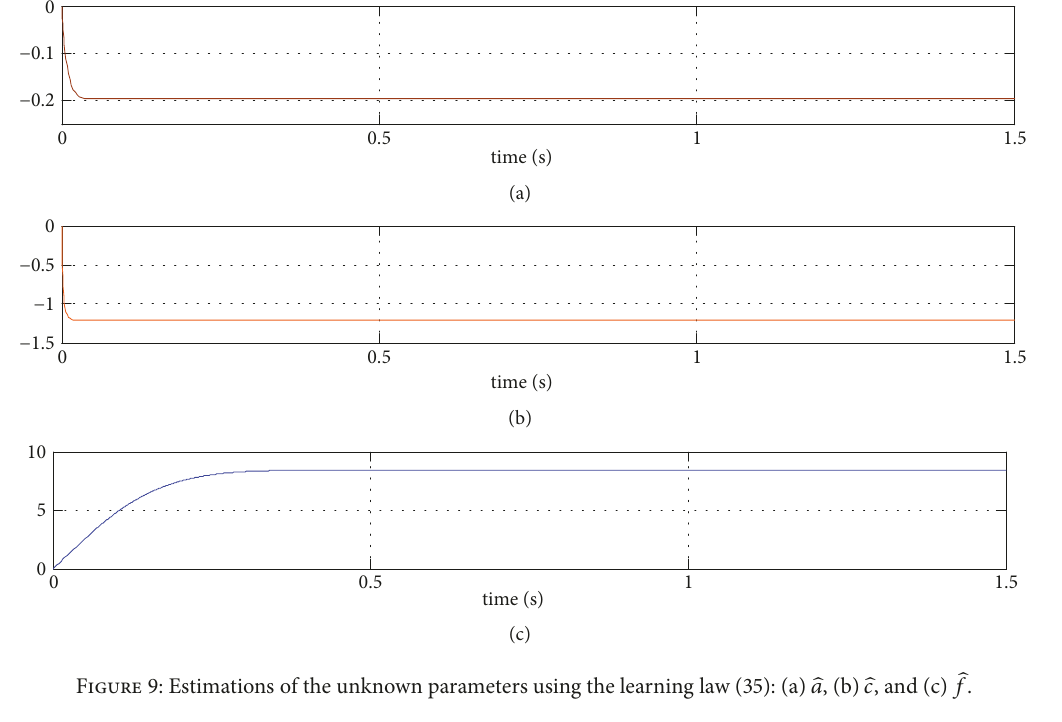
Figure 9: Estimations of the unknown parameters using the learning law (35): (a) ̂𝑎 , (b) ̂𝑐 , and (c) (a) the states of slave system, the synchronization error,